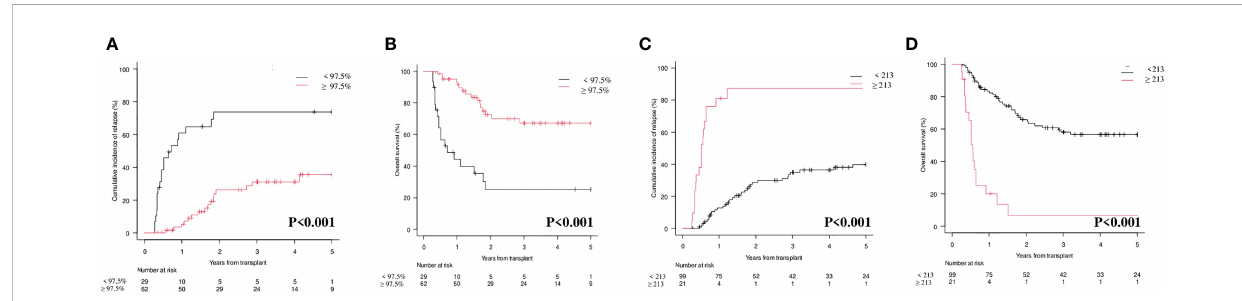
FIGURE 3 Cumulative Incidence of Relapse (CIR) and Overall Survival (OS) according to molecular chimerism on CD34+ cells and WT1 levels at 3rd month. (A) CIR at 1 year CD34+ ≥ 97.5% vs <97.5% donor: 5.3% (95% CI 1.4-13.4) vs 61% (95% CI 40.3-76.4). (B) OS at 1 year CD34+ ≥ 97.5% vs <97.5% donor: 93.1%